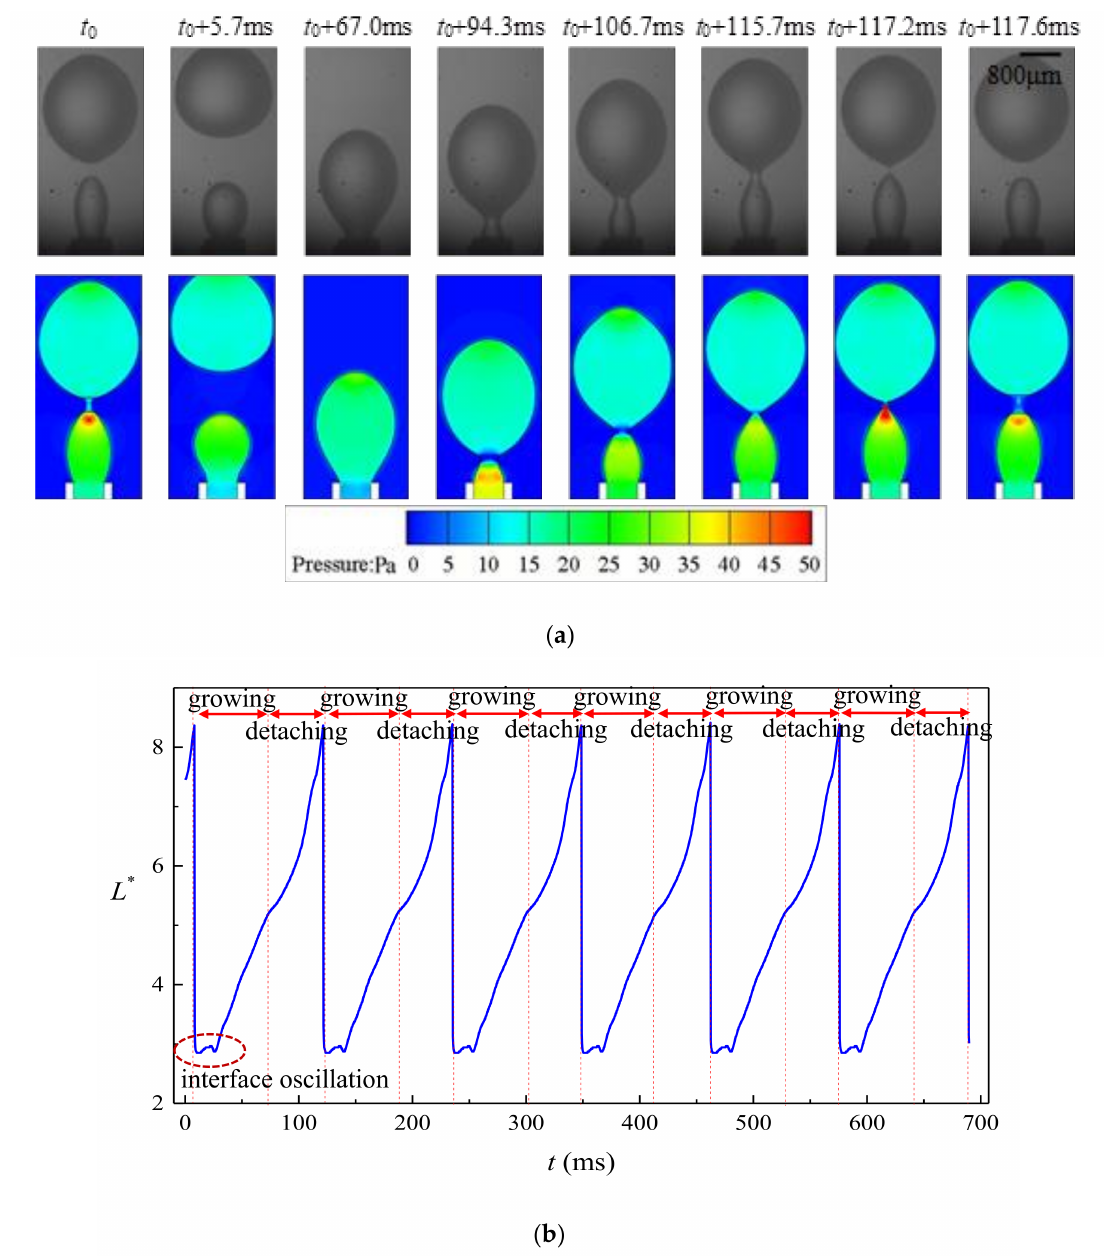
Figure 8. Typical transitional regime ( q d = 75 mL / h, We = 0.13, Bo = 0.027) with 0.5 wt% SDS in water: ( a ) experimental snapshots and numerical simulation; ( b ) variation of droplet length reconstructed from numerical